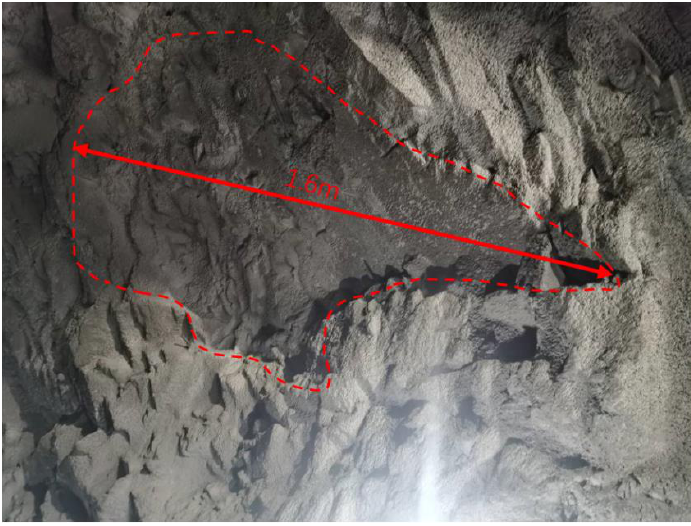
Figure 14. Block fall along the structural plane at stake 0+443 m.